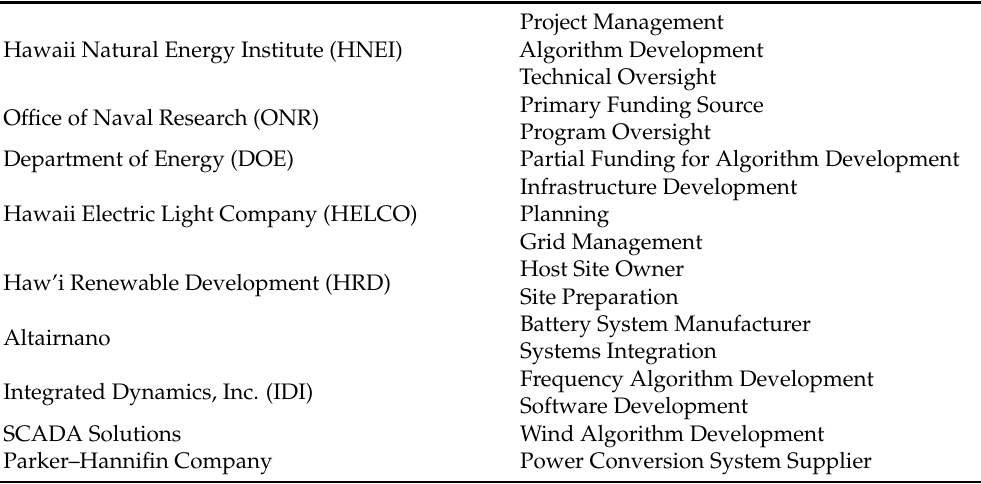
Table 1. List of funding sources and partners for Hawaii Battery Energy Storage Systems (BESS) project.